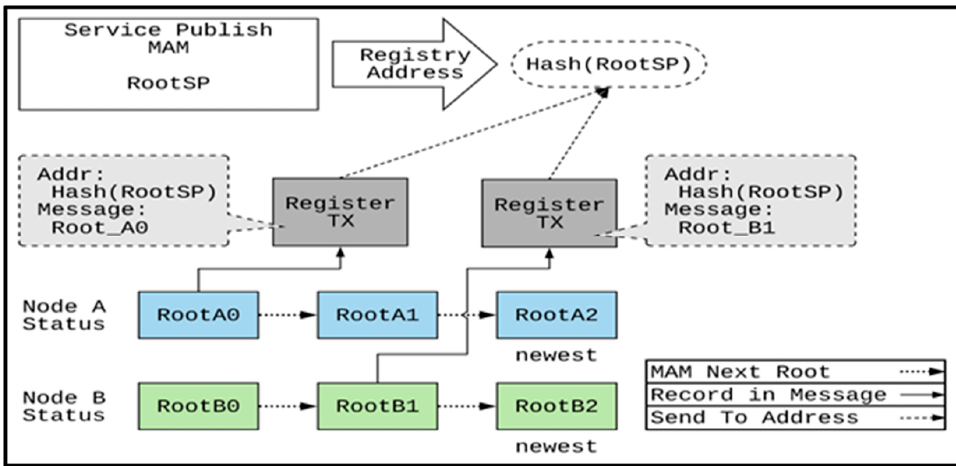
Figure 3. Registration of service nodes .